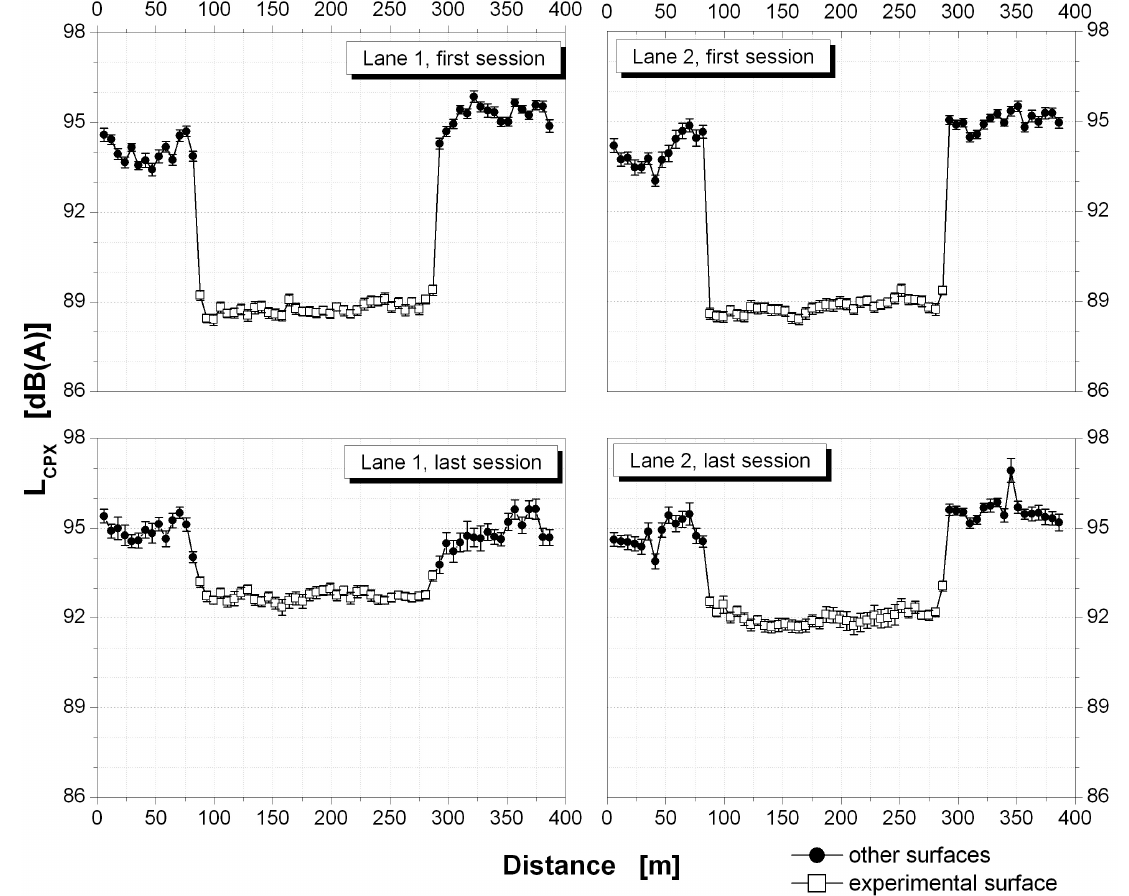
Figure 14. CPX data spatial distribution obtained during first session (upper figures) of measurements and during last one (lower figures) at Site 4. Lane 1 results are represented on the left plots while lane 2 ones are on the right plots. Experimental stretches data are marked with white